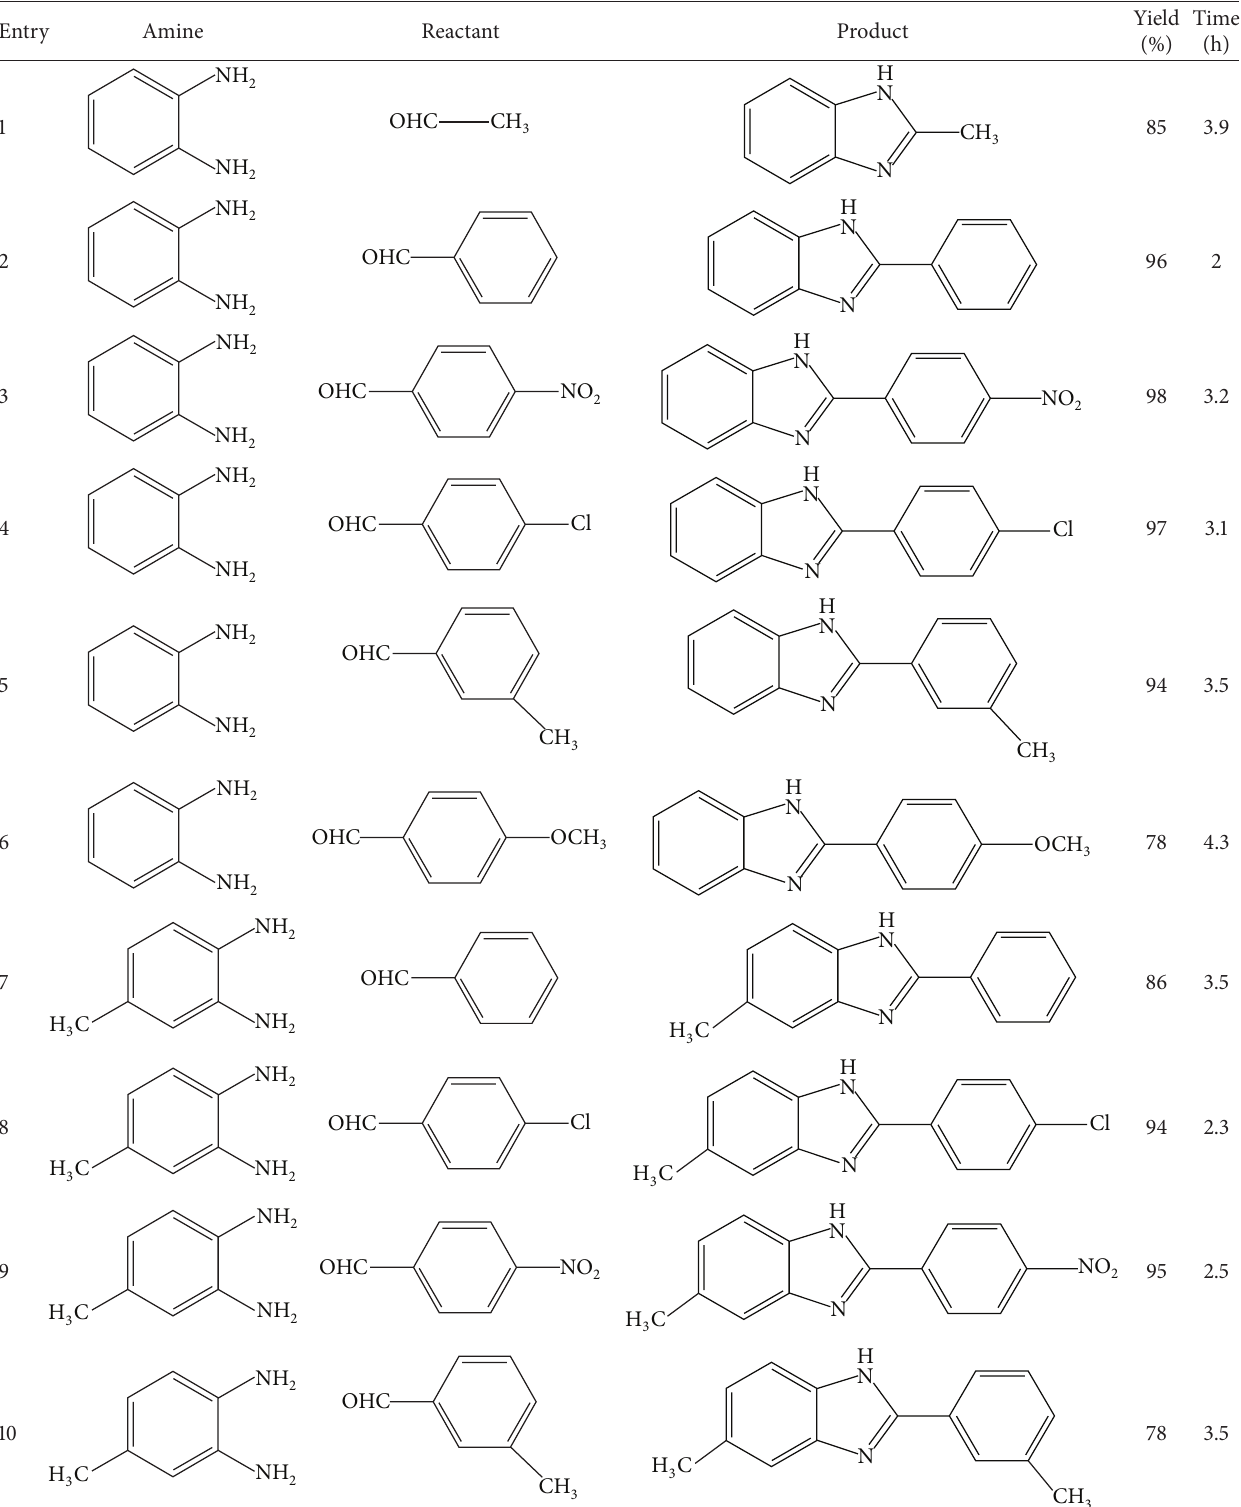
Table 2: Synthesis of substituted benzimidazoles by ZrO(NO o